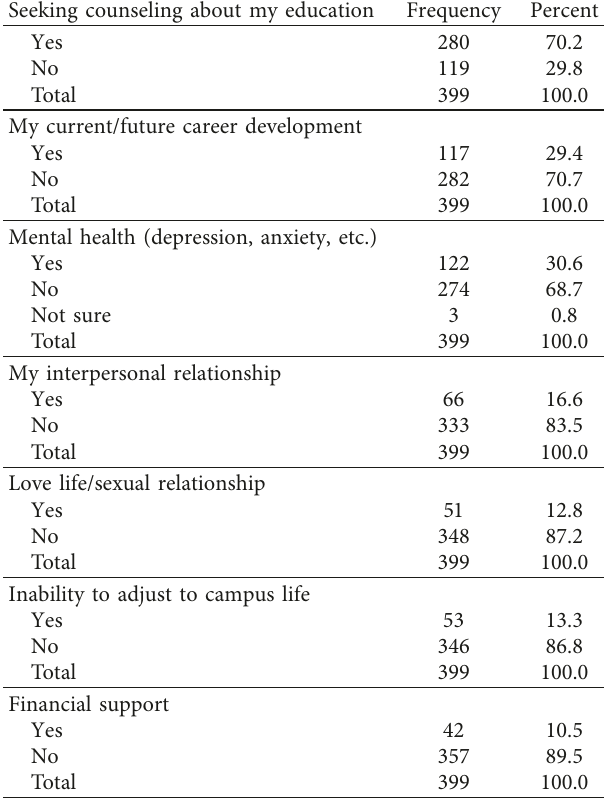
Table 5: Identified counseling needs of students in higher